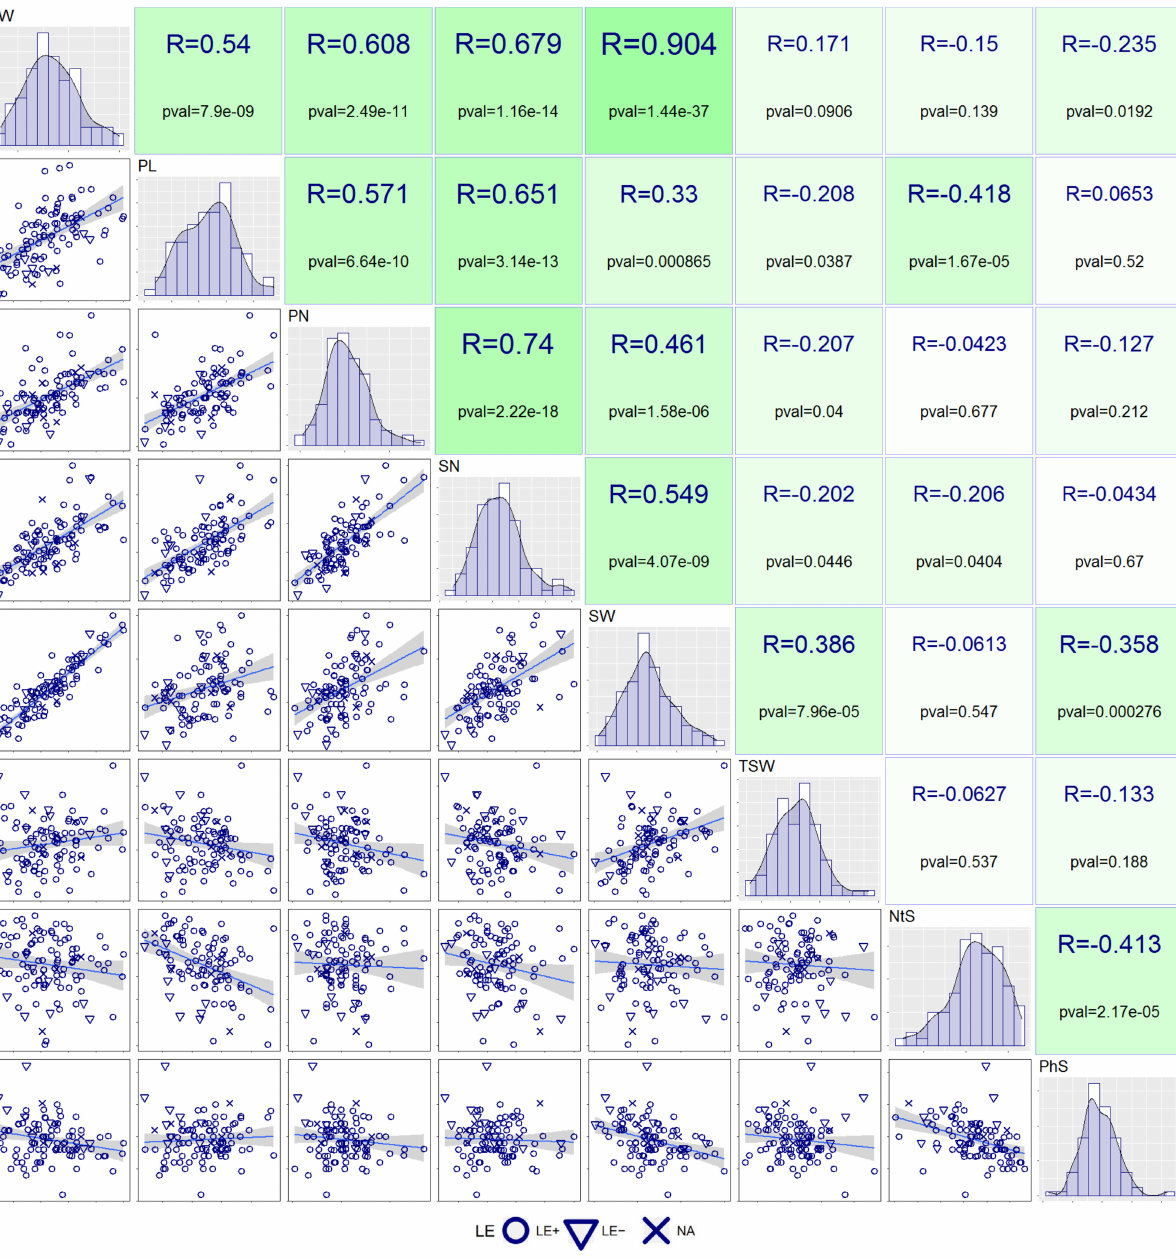
Figure 3. Correlation matrix plot showing the results of pairwise correlation analysis of AM-caused increments of the analyzed traits. The lower triangular matrix is composed of scatter plots. The upper triangular matrix shows the Pearson correlation coefficients with p -values. The matrix diagonal comprises the distribution plots (histogram + density) of the traits. The following traits are presented: PW—shoot weight, g; PL—shoot length, cm; PN—pod number; SN—seed number per plant; SW—seed weight per plant, g; TSW—thousand-seed weight, g; NtS—seed nitrogen content, mg/g; PhS—seed phosphorus content,